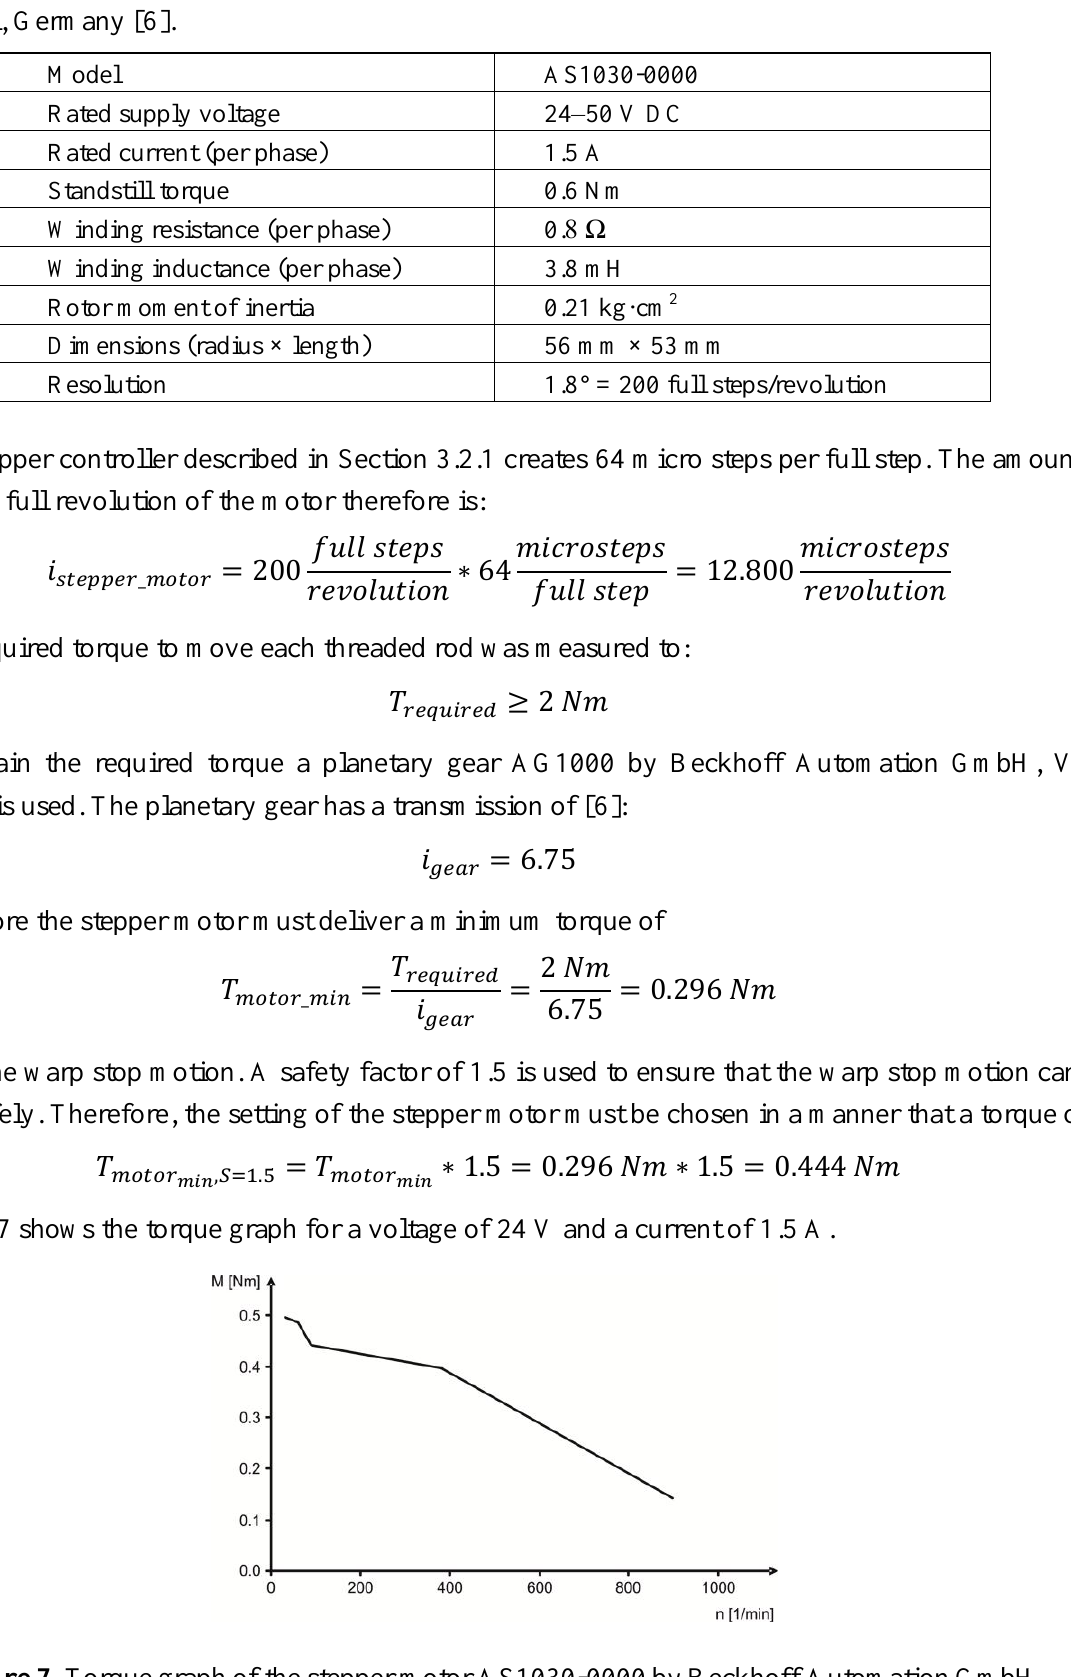
Figure 7. Torque graph of the stepper motor AS1030-0000 by Beckhoff Automation GmbH, Verl, Germany